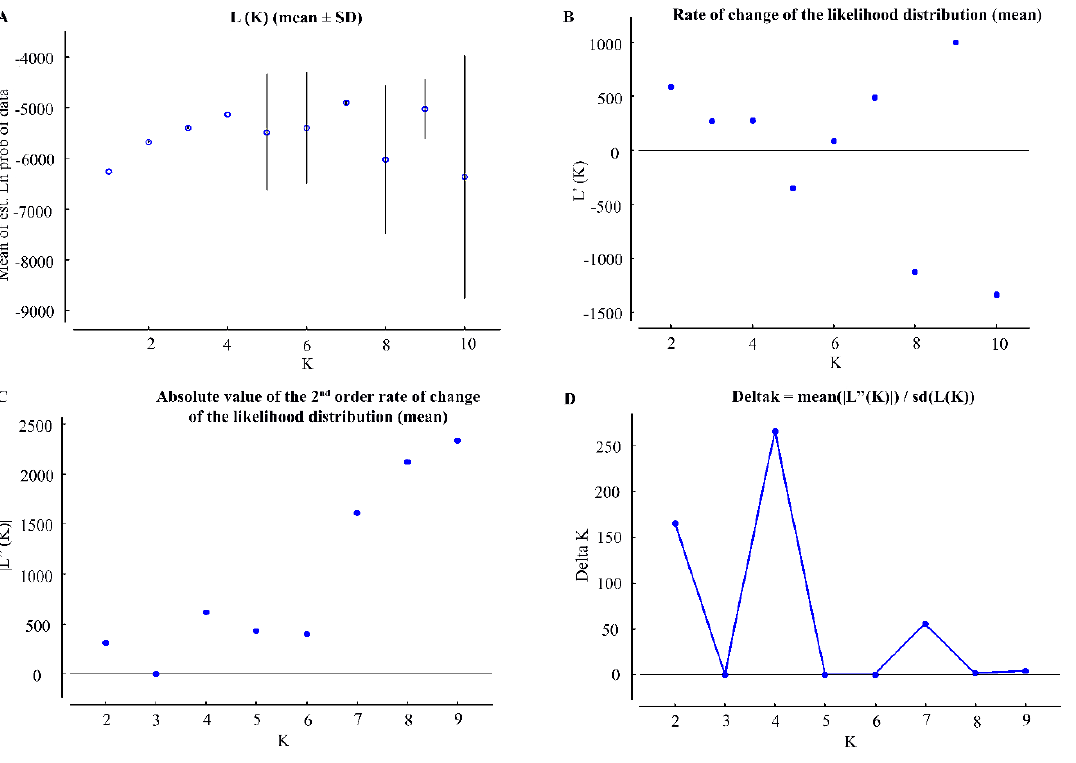
Figure 7. Structure Harvester analysis showing the ∆ K value of 58 Phyllostachys species (Asian bamboo) based on inter-retrotransposon amplified polymorphism (IRAP) markers. ( A ), mean of estimated Ln probability; ( B ), rate of change of the likelihood distribution (mean); ( C ), absolute value of the 2nd order rate of change of the likelihood distribution (mean); ( D ), ∆ K = mean( | L”(K) | ) / sd(L(K)). ∆ K = 4 indicates the maximum K value.